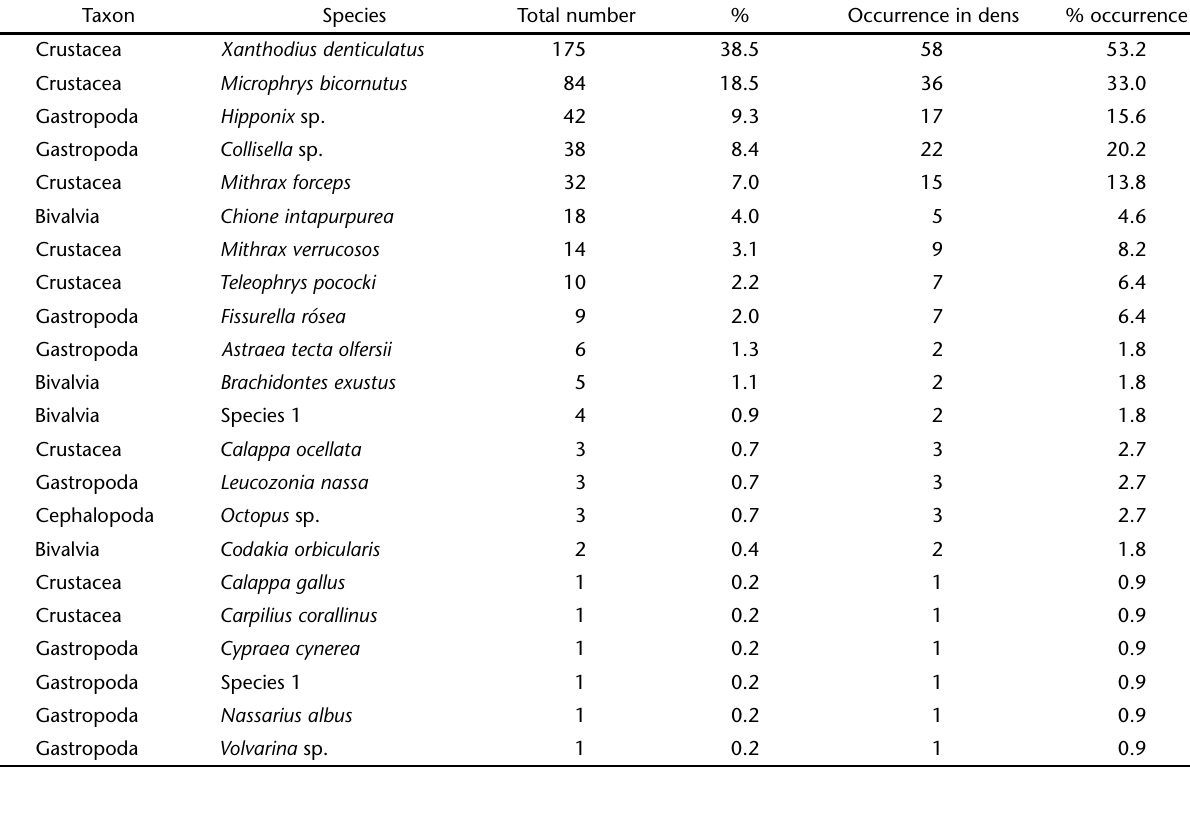
Table III. Prey of O. insularis (n = 473) found in the middens on Rocas Atoll, between 2003 and